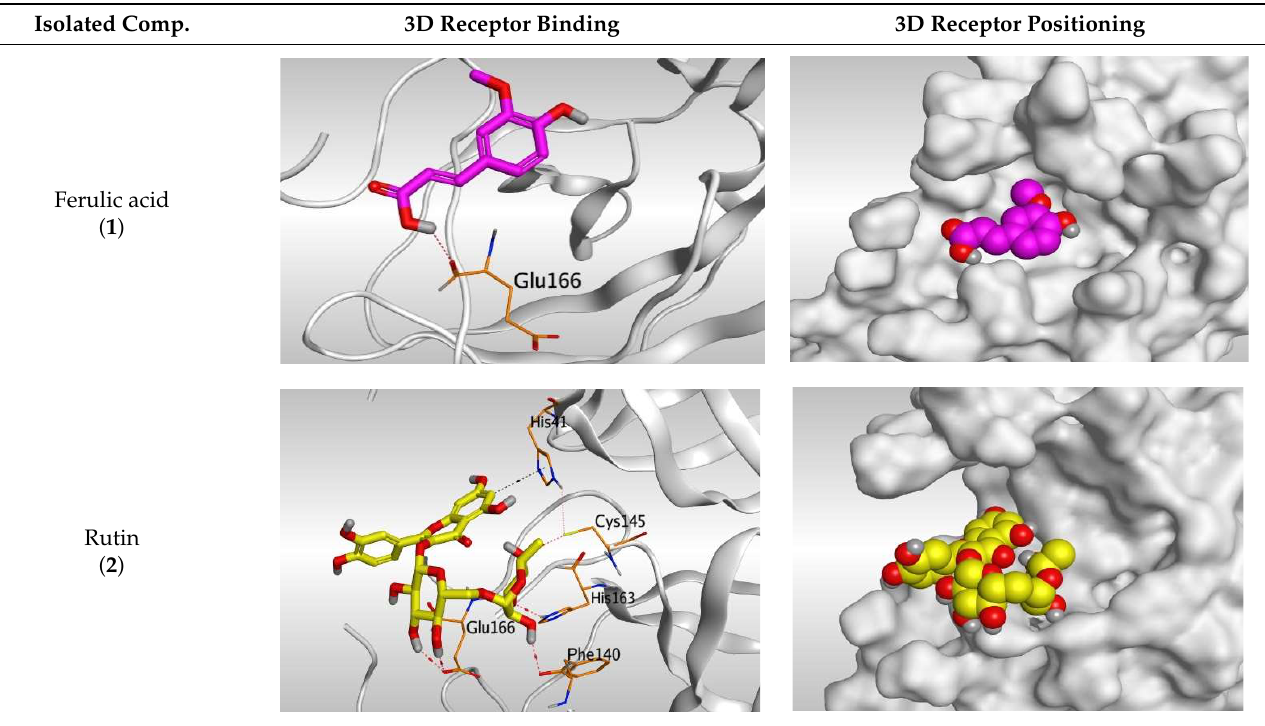
predicted pose and the crystal structure.